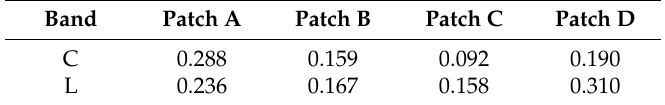
Table 1. Averaged numerator of ratio of correlation coefficient for different wavebands.